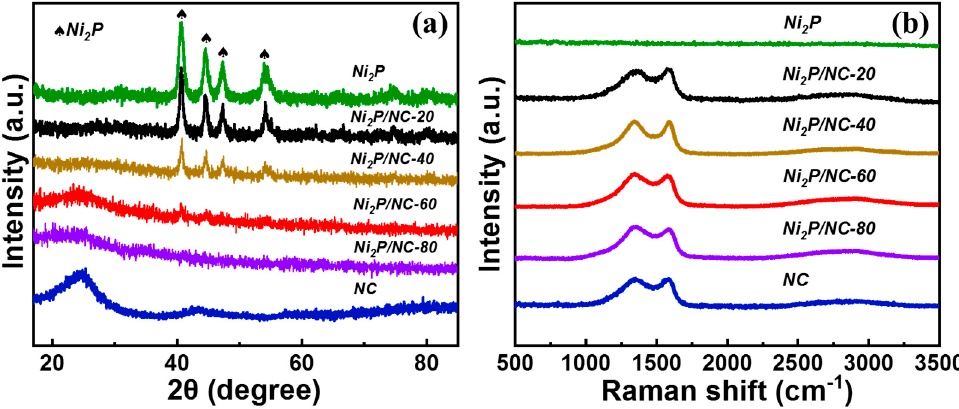
Figure 3. XRD patterns ( a ) and Raman spectra ( b ) of di ff erent components of materials.